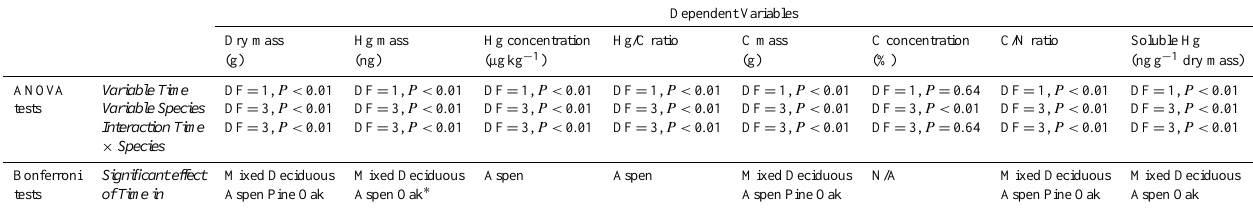
Table 2. Results of statistical Analysis Of Variance (ANOVA) and Bonferroni post-hoc tests to test for effects of incubation time (continuous variable), species (categorical variable), and interactions for the dependent variables: dry mass, Hg mass, Hg concentration, Hg/C ratio, C mass, C concentration, C/N ratio, N mass, N concentration, and soluble